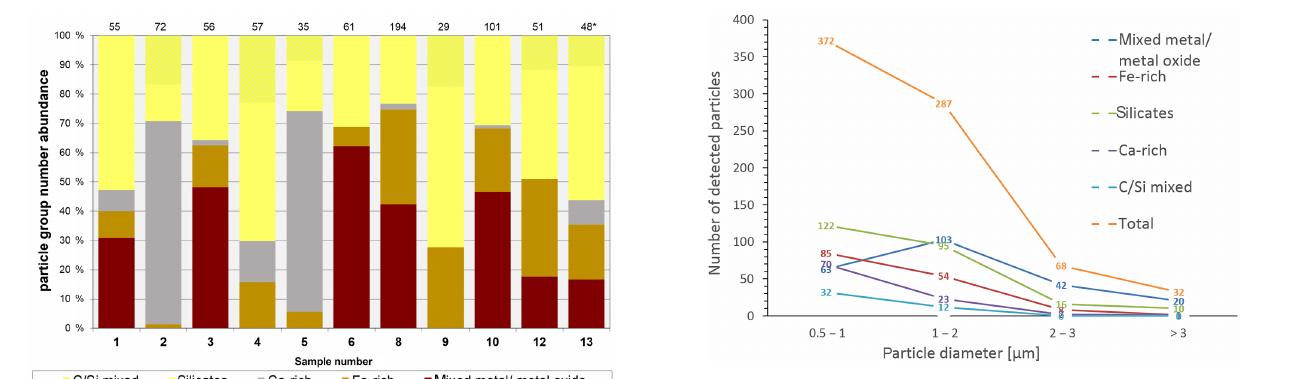
Figure 9. Size distribution of refractory particles during RECON- CILE (coarse